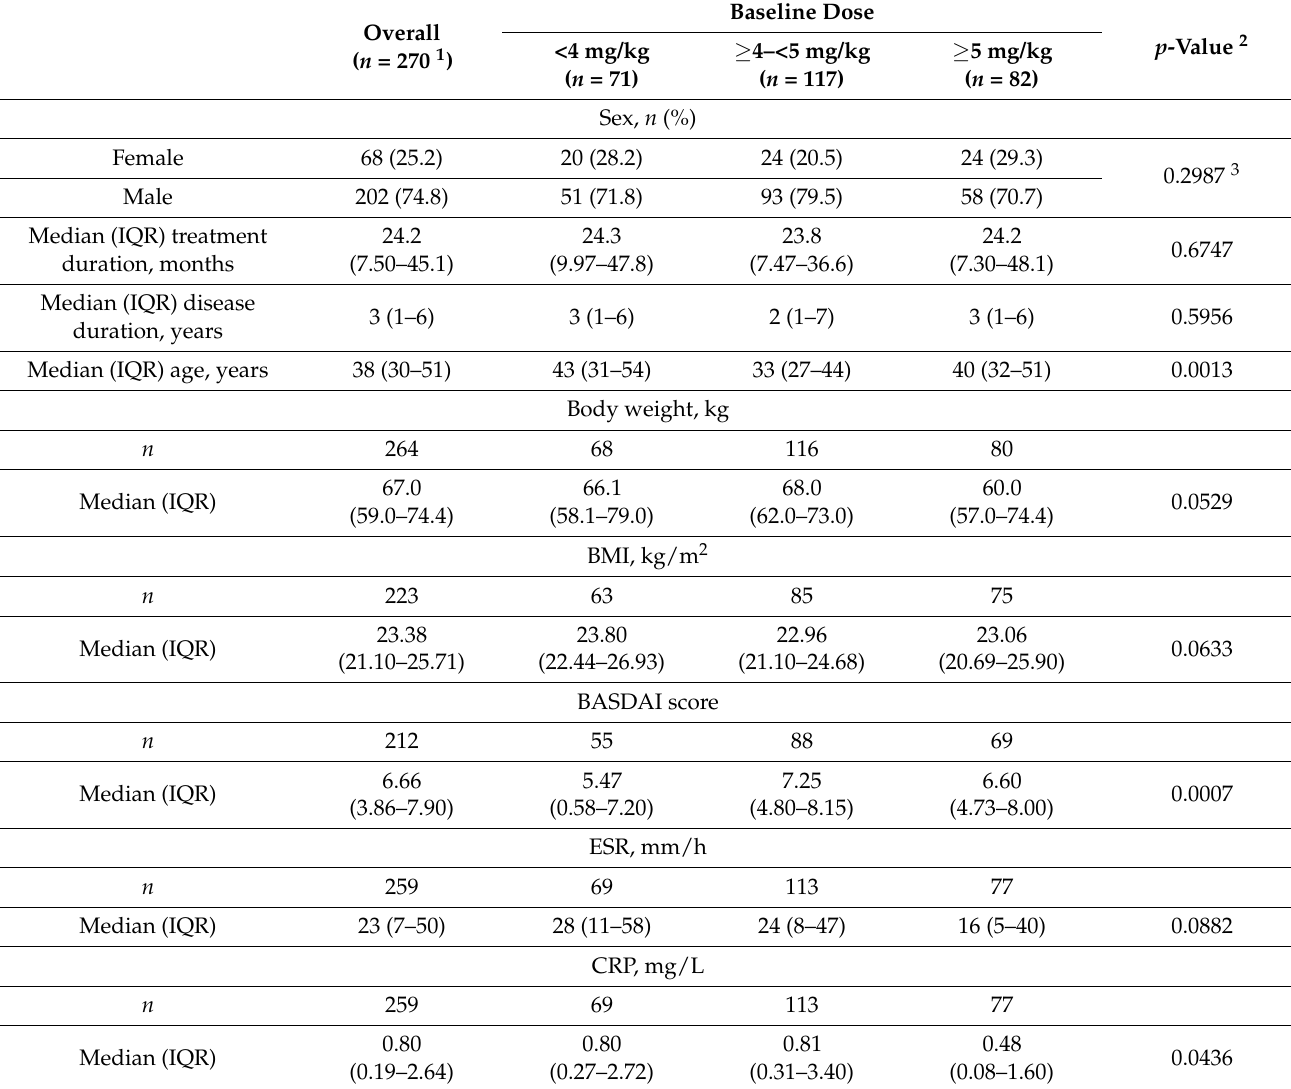
lower baseline BASDAI scores than naïve patients across baseline dose groups (Tables S1 and S2). Naïve patients with lower baseline doses tended to have lower baseline BASDAI scores, although differences between groups were not significant (Table S1). For switched patients, differences in baseline BASDAI score were significantly different between baseline dose groups, with median scores of 0.57, 1.01, and 4.24 in the <4 mg/kg, ≥ 4–<5 mg/kg, and ≥ 5 mg/kg baseline dose groups, respectively (Table S2). Table 1. Baseline demographics and disease characteristics by baseline dose (overall